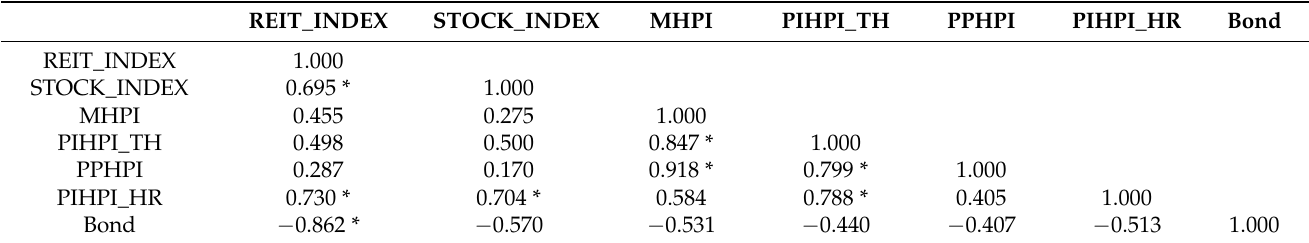
Table 5. Pearson Correlation Coefficient of Investment Assets.